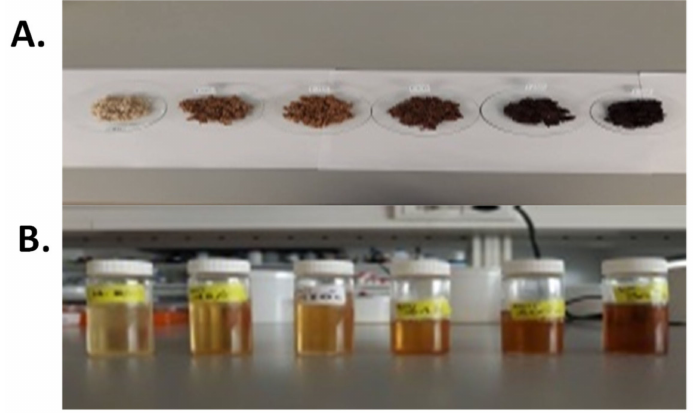
Figure 1. ( A ) Unroasted and roasted sesame seeds at different temperatures (top) and ( B ) their corre- sponding oils (bottom). From right to left: unroasted, roasted at 150, 180, 210, 250 and 300 ◦ C,